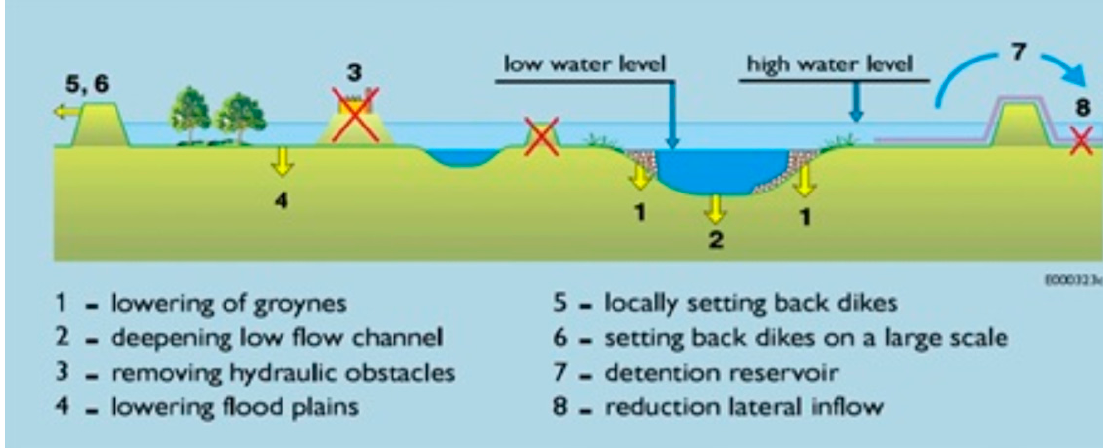
Figure 3. Measures applied in the “Room for the River” project in the Netherlands [88].